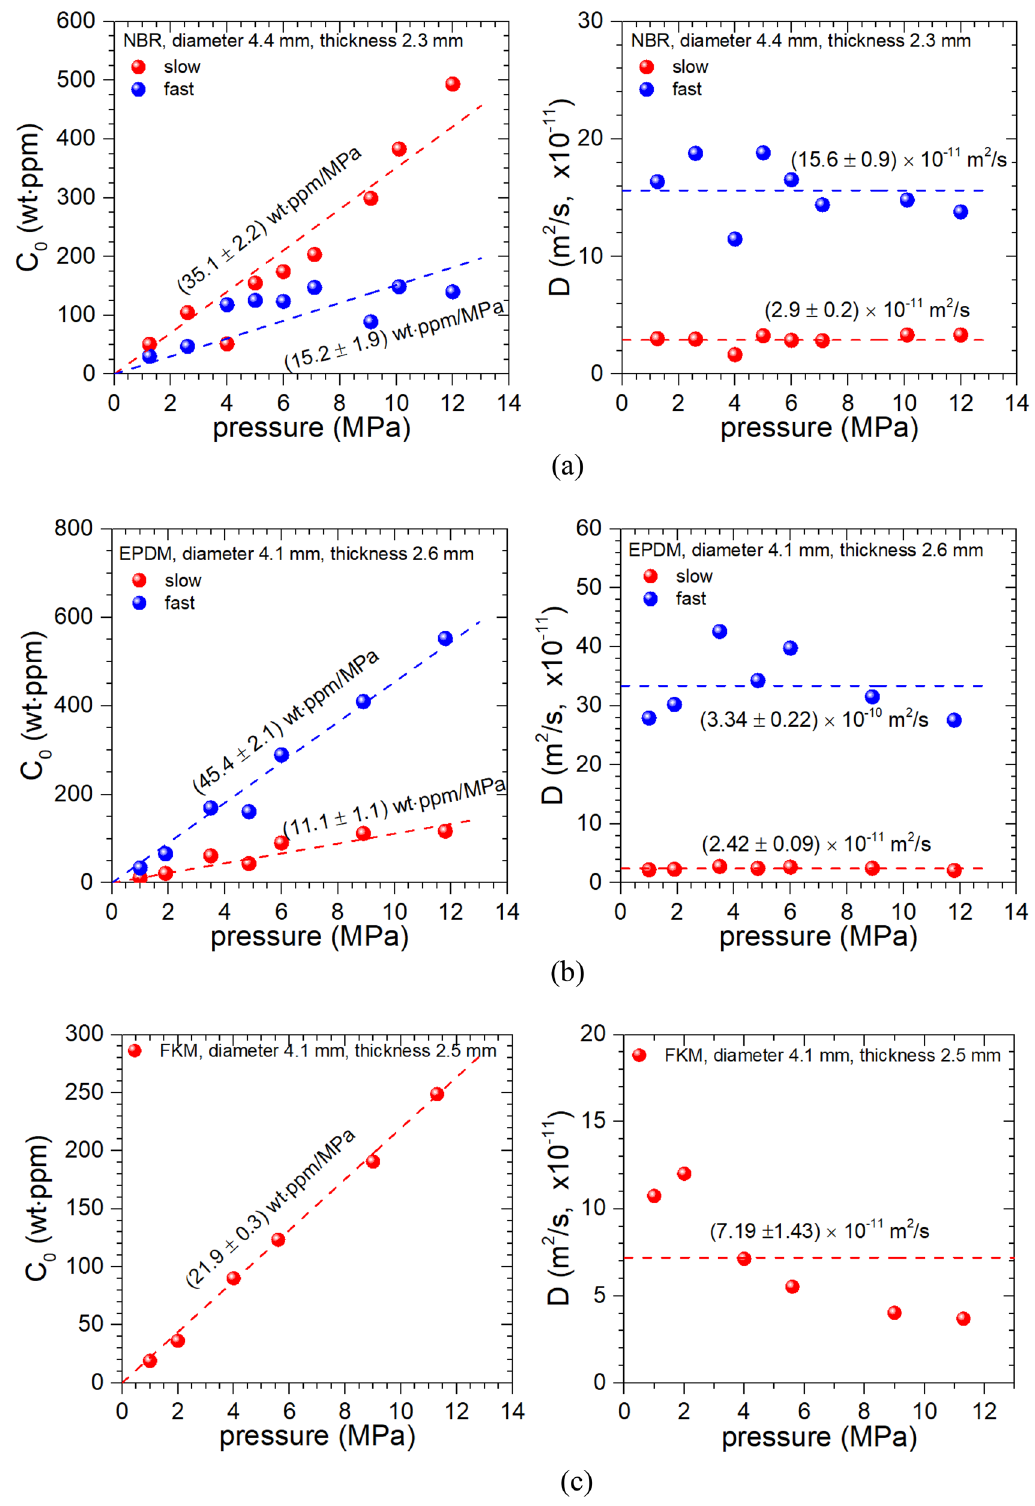
Figure 9. H 2 content (left) and diffusivity (right) of ( a ) NBR, ( b ) EPDM and ( c ) FKM versus